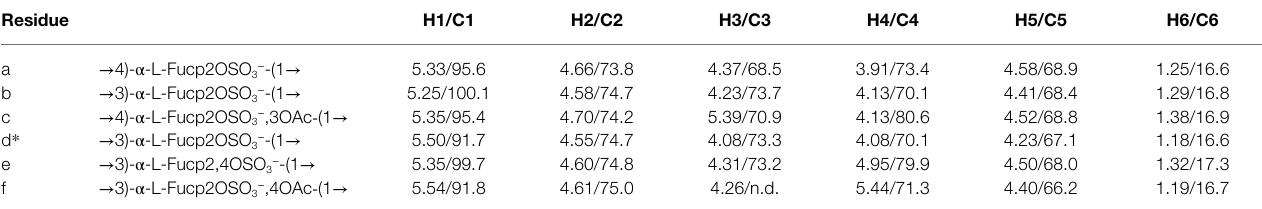
10 ). Spectrum and